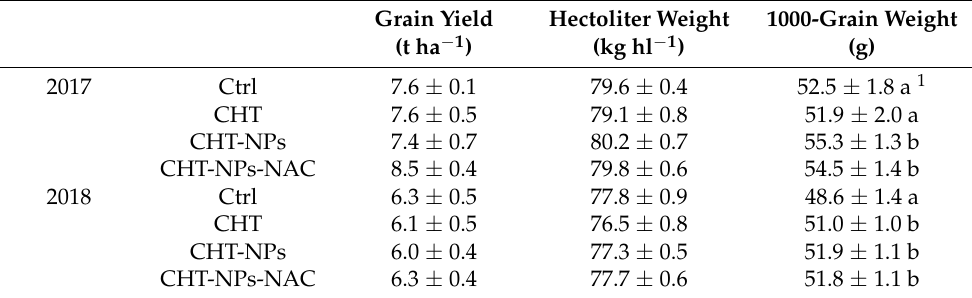
Table 1. Mean values ± standard deviation of crop yield parameters measured in 2017 and 2018 in Triticum durum cv. Fabulis untreated (Ctrl) or treated with CHT, CHT-NPs, or CHT-NPs-NAC.